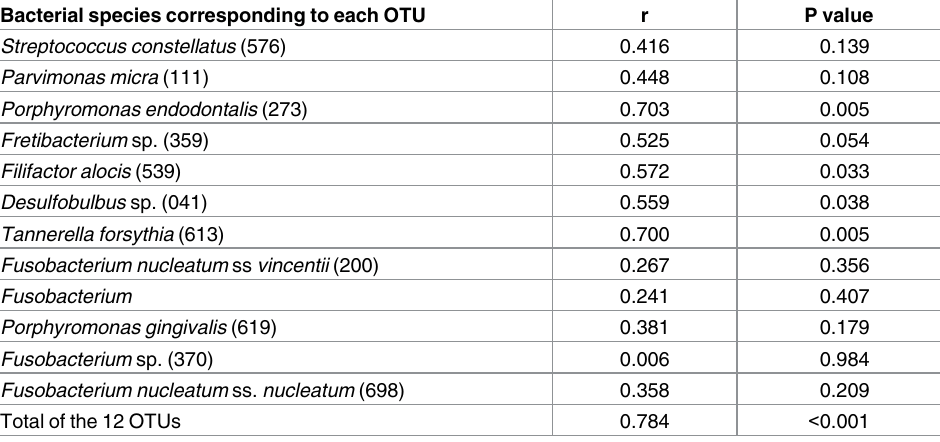
Table 1. Correlation of the relative abundance of each SUBP-specific OTU in SL and the percentage of sites with periodontal pockets ( (cid:21) 4 mm depth). Bacterial species corresponding to each